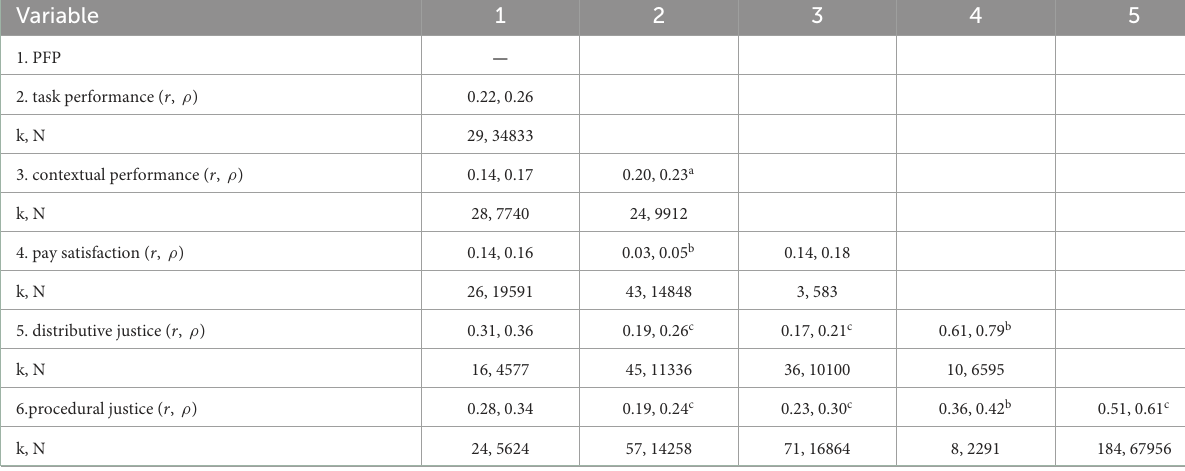
TABLE 4 Correlations among justice and job performance outcomes. Variable